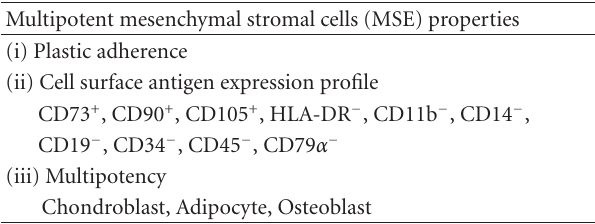
Table 1: Standardized requirements for MSC